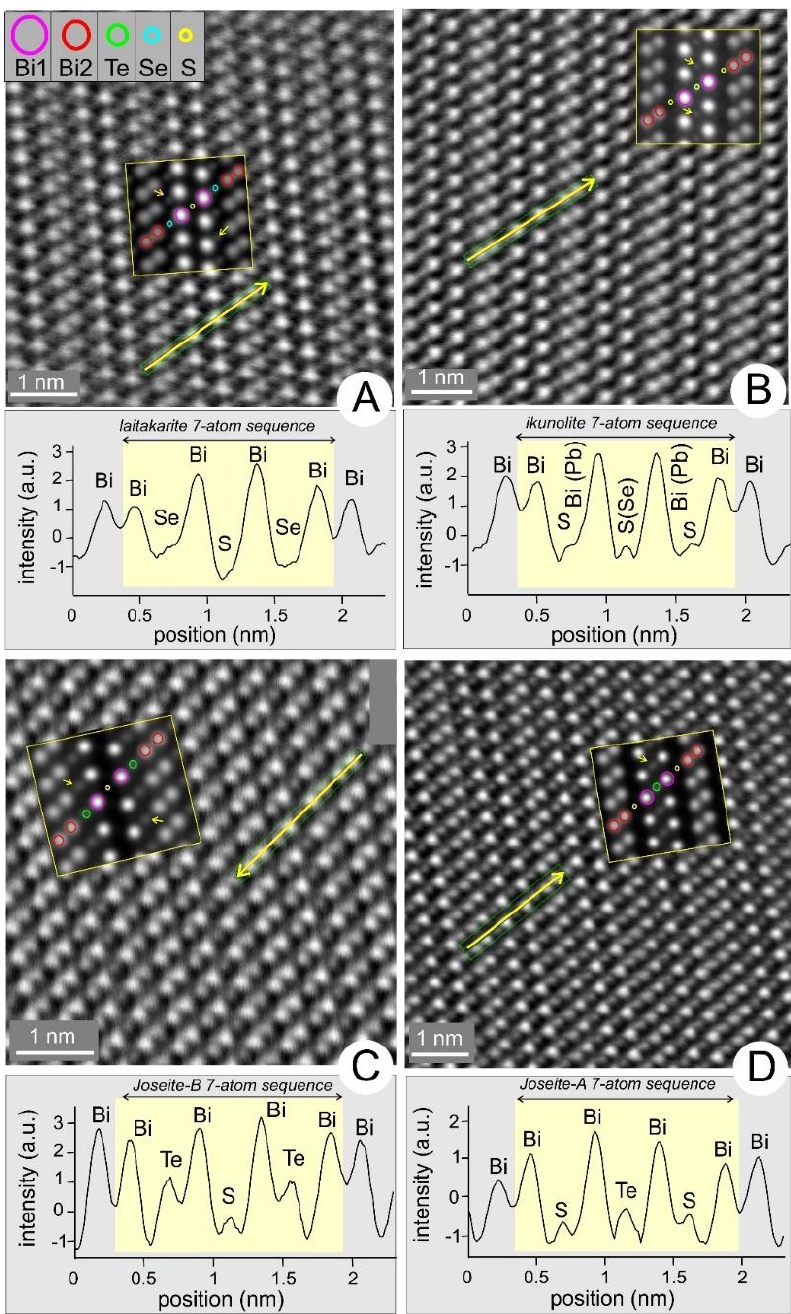
Figure 8. High-resolution HAADF STEM images (obtained by DCFI procedures and filtered to eliminate noise) and intensity profiles (below each image) for ikunolite ( A ), laitakarite ( B ), joséite-B ( C ), and joséite-A ( D ). Yellow arrows show the location and direction of the HAADF intensity profiles. Insets outlined in yellow are STEM simulations showing the distribution and speciation of the seven-atoms across a single layer. The simulations were obtained using the atomic coordinates for structures (.cif files for the end-member tellurides shown in Figure 1) but with compositional modifications for cation mixed sites/chalcogen speciation within the seven-atom sequence according to EPMA data. Chalcogens that are visible on the STEM simulations are marked by short arrows. Note variation in signal intensity for Bi positions, whereby the Bi–Bi pairs (Bi2 position) have a lower intensity than the two ‘internal’ Bi atoms (Bi1) that alternate with chalcogens and which are better separated on the images. This effect is attenuated on the images/profile for joséite-B more than in the STEM simulation.